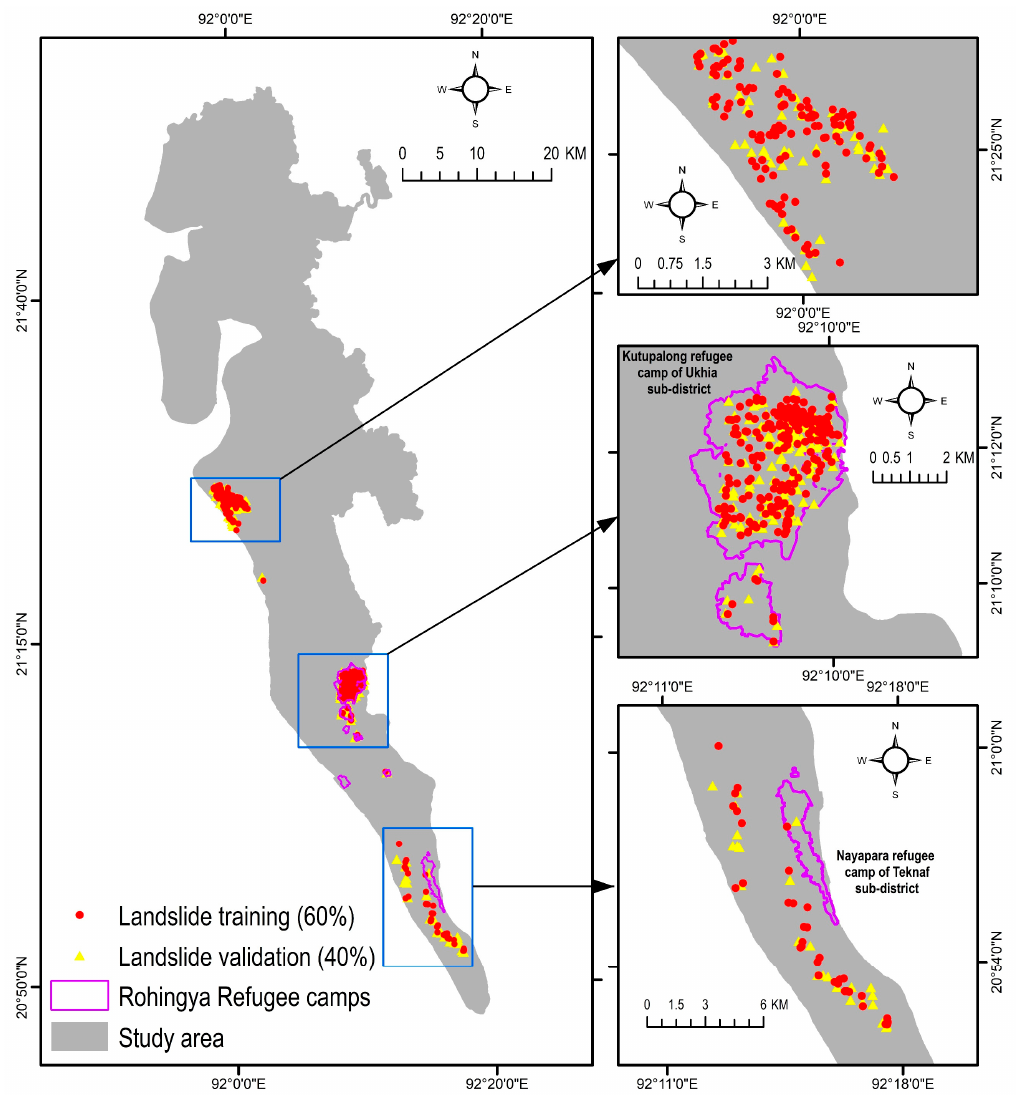
Figure 3. Landslide inventory map of this study. Data source: [11].